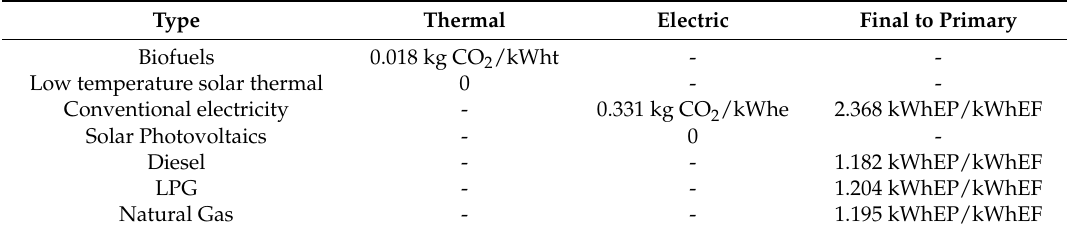
Table 1. Energy conversion